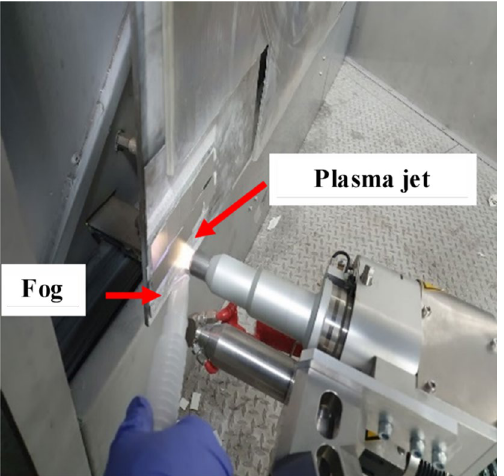
Figure 1. Experimental assembly of the technique for surface treatment and deposit of coatings by